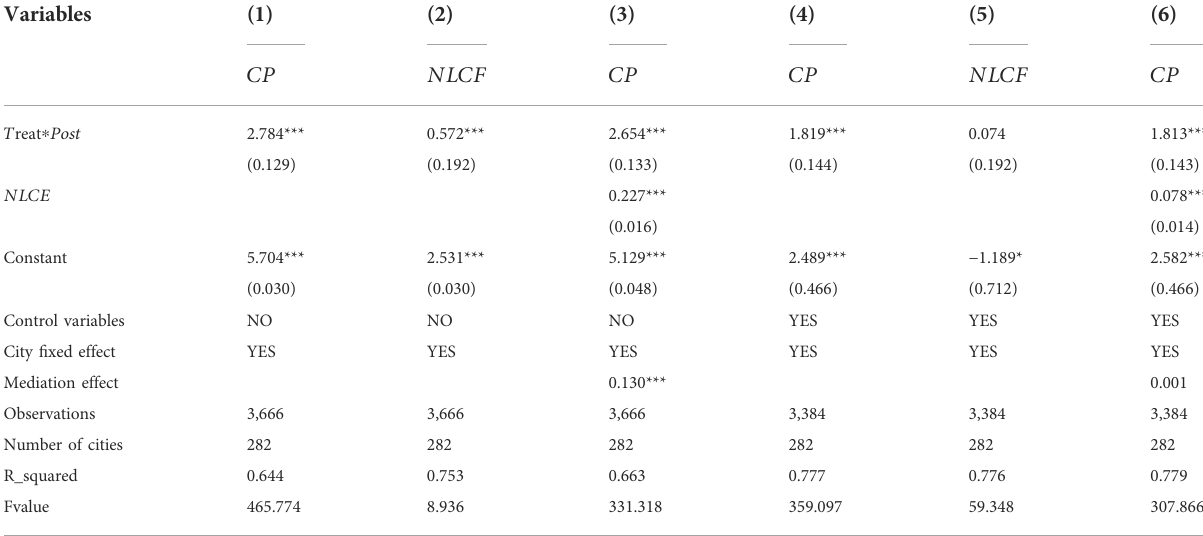
TABLE 11 Estimation results based on the number of registrations of low-carbon-type enterprises. Variables